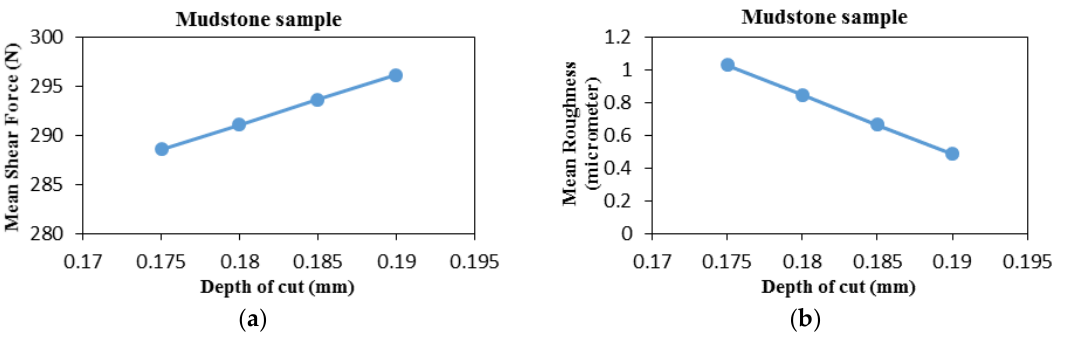
Figure 25. Evolution of ( a ) the mean cutting force and ( b ) the mean groove asperity versus DOC in